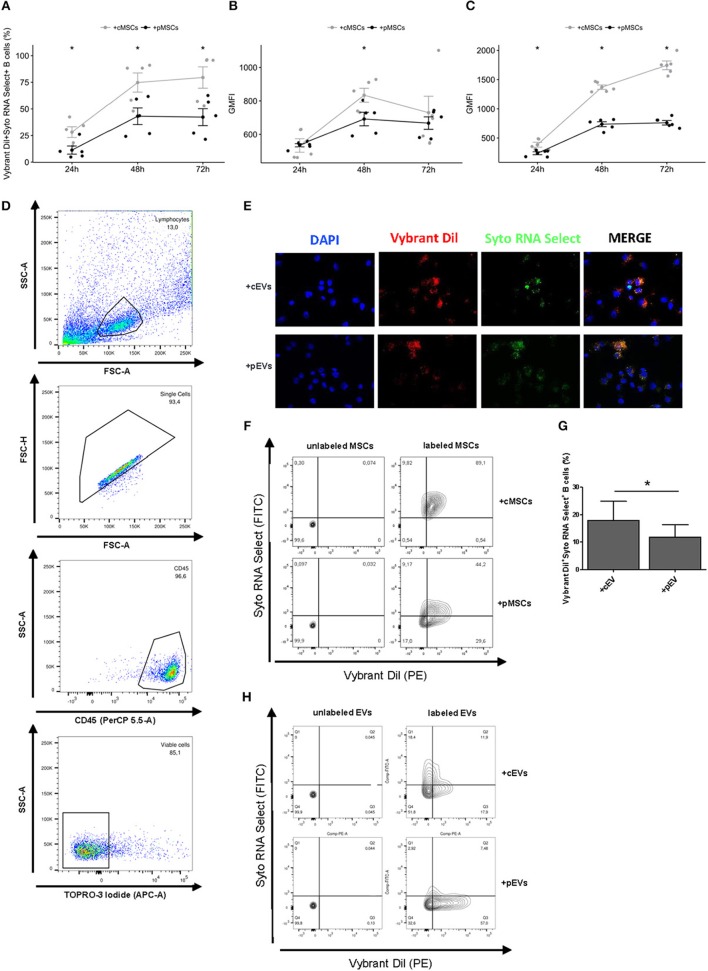
Incorporation of MSC-EVs and RNA transfer in activated B lymphocytes. (A) Percentage of Vibrant DiI+ Syto RNA Select+ B cells co-cultured for 24, 48, and 72 h with double stained resting or primed MSCs (n = 5) *p < 0.05. (B) Vybrant Dil Geometric Mean of Fluorescence Intensity (GMFI) of B cells co-cultured with double stained resting or primed MSCs. (C) Syto RNA Select GMFI of B cells co-cultured with double stained resting or primed MSCs. (D) Representative gating strategy on the final gated population. (E) MSC-EVs were double-stained for membrane in red (Vybrant Dil) and for RNA in green (Syto RNA Select). Labeled EVs were incubated for 24 h on activated B lymphocytes. The four panels show (from the left to the right) B cells stained with DAPI (blue), the internalization of membrane components of cEVs and pEVs (red), the distribution of Syto RNA Select carried by MSC-EVs inside B cells (green), and a merge between the three previous panels (original magnification 400x). The images are representative for three independent experiments with similar results. (F) Representative FACS analysis of Vibrant DiI+ Syto RNA Select+ B cells co-cultured with double stained (right) or not (left) resting or primed MSCs. (G) Percentage of Vibrant DiI+ Syto RNA Select+ B cells co-cultured for 24 h with double stained resting or primed MSC-EVs (n = 5) *p < 0.05. (H) Representative FACS analysis of Vibrant DiI+ Syto RNA Select+ B cells co-cultured with double stained (right) or not (left) resting or primed MSC-EVs.